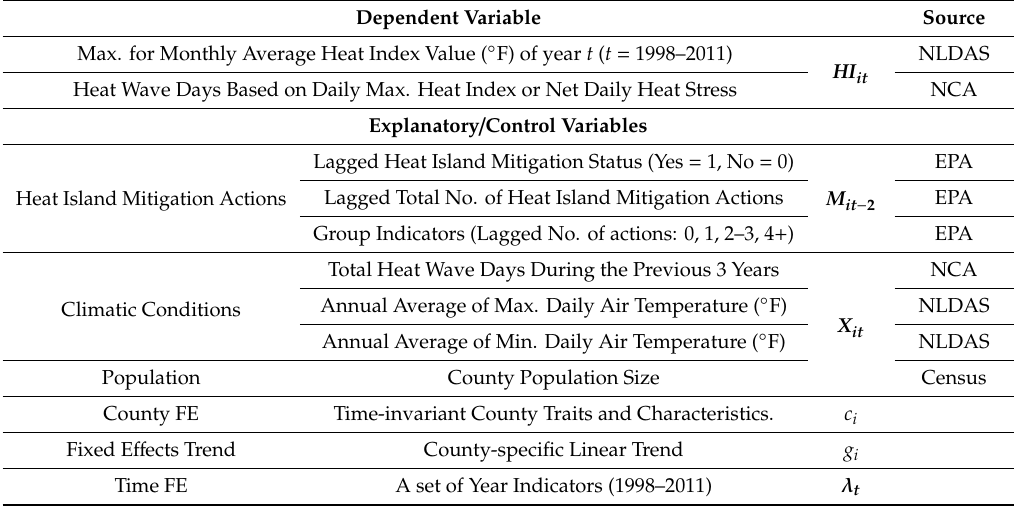
Table 2. List of variables in the heat hazard mitigation